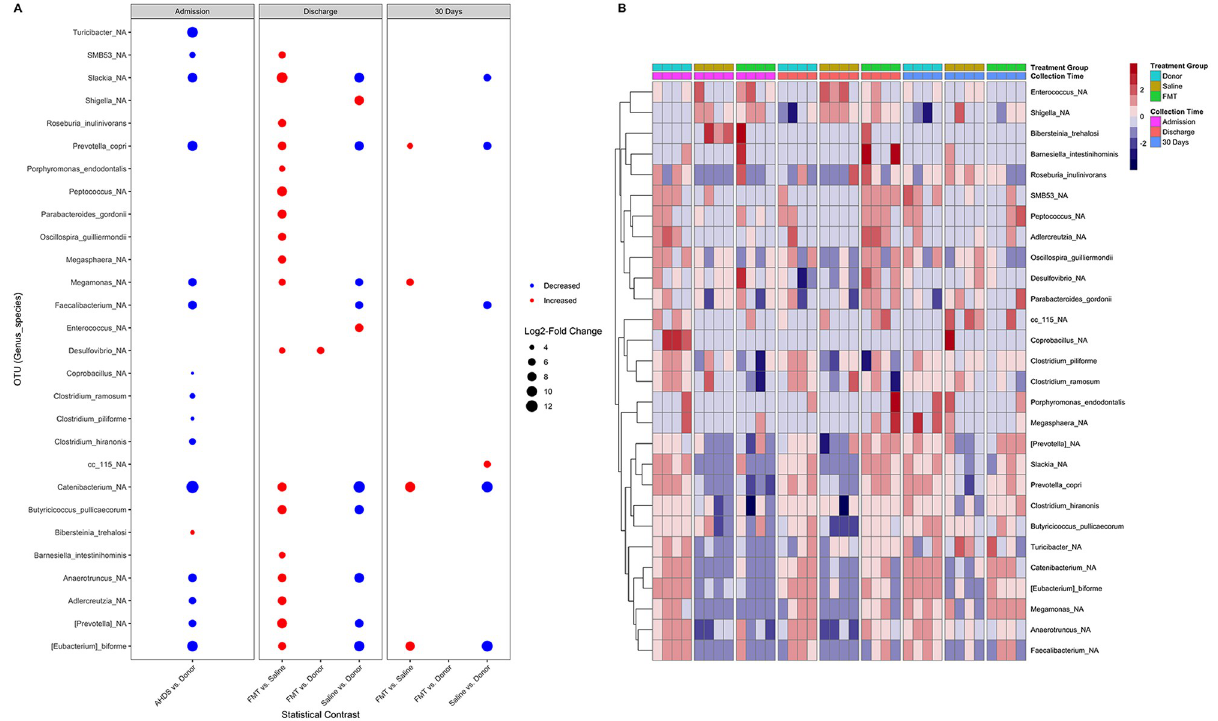
Fig 6. Differentially abundant taxa associated with FMT. (A) An empirical Bayesian linear model was used to detect differentially abundant taxa associated with AHDS and FMT. Taxa are present on the y-axis and the specified statistical comparisons are represented on the x-axis. The color of each point corresponds to whether the taxon was increased (red) or decreased (blue). The size of each point is proportional to the log2 of the fold- change between the specified groups. (B) Heatmap of the OTU abundance demonstrating broad shifts in communities of FMT recipients AHDS: acute hemorrhagic diarrhea syndrome; FMT: fecal microbial